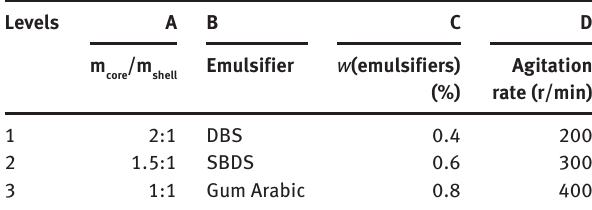
Table 1: Experimental factors and levels. Levels